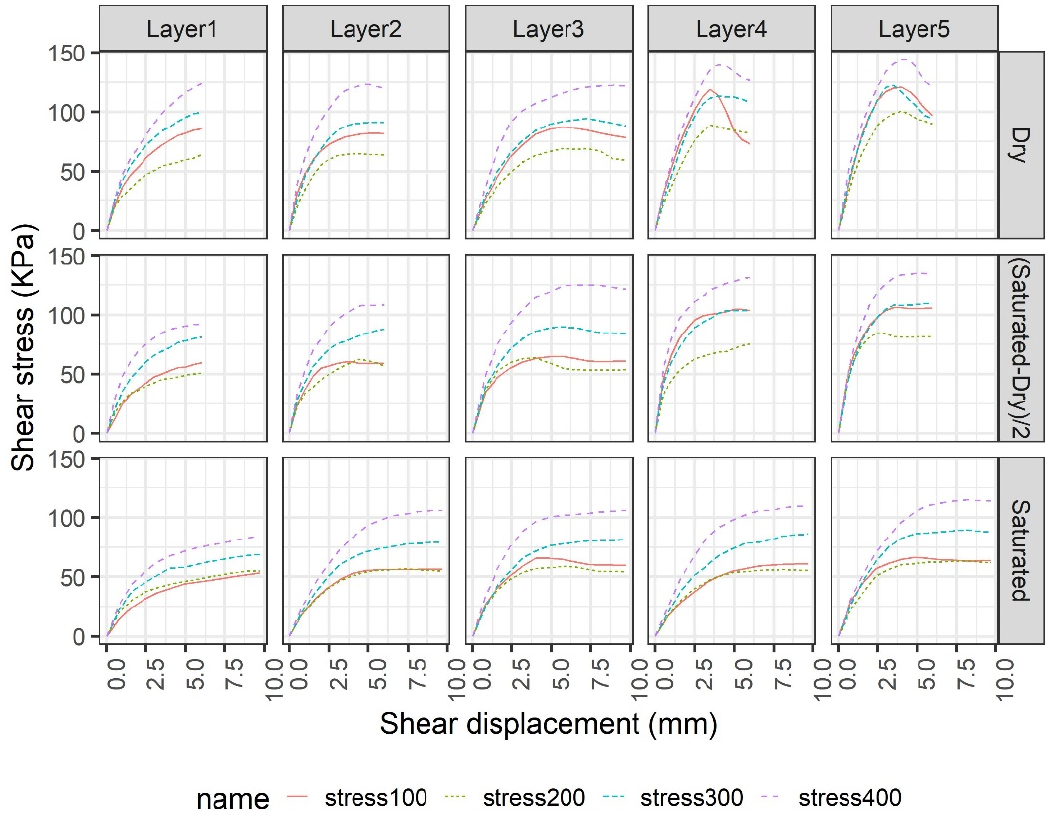
Figure 7. Shear stress–shear displacement relationship of five soil layers at the different saturated conditions.